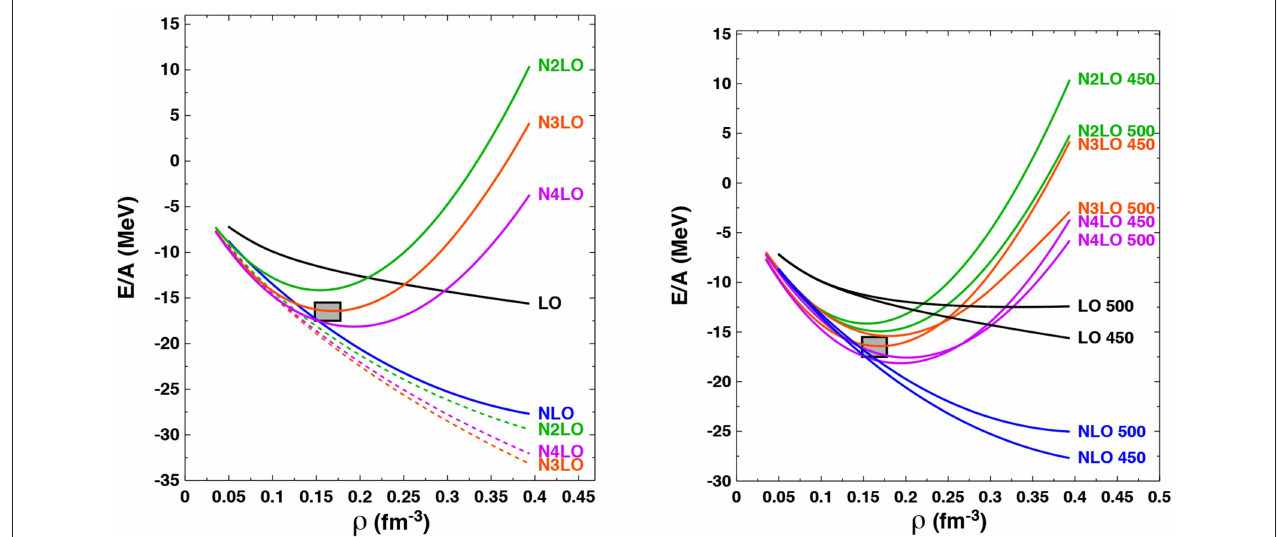
FIGURE 2 | (Left) Ground state energy per particle of SNM as a function of density from the chiral two- and three-body forces with cutoff 3 = 450MeV. The three dotted curves show predictions which include only two-body forces. For the 3NF contributions at N 2 LO and above, the LECs of Table 2 are used. The shaded box locates the approximate empirical saturation energy and density. (Right) Ground state energy per particle of SNM as a function of density at the indicated orders and with varying cutoff parameters. Other details as on the